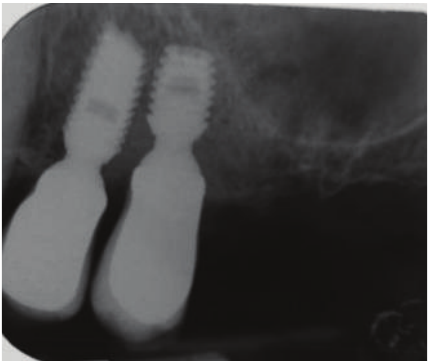
Figure 9: The mucoperiosteal flap was repositioned to ensure transmucosal healing and proper wound closure.